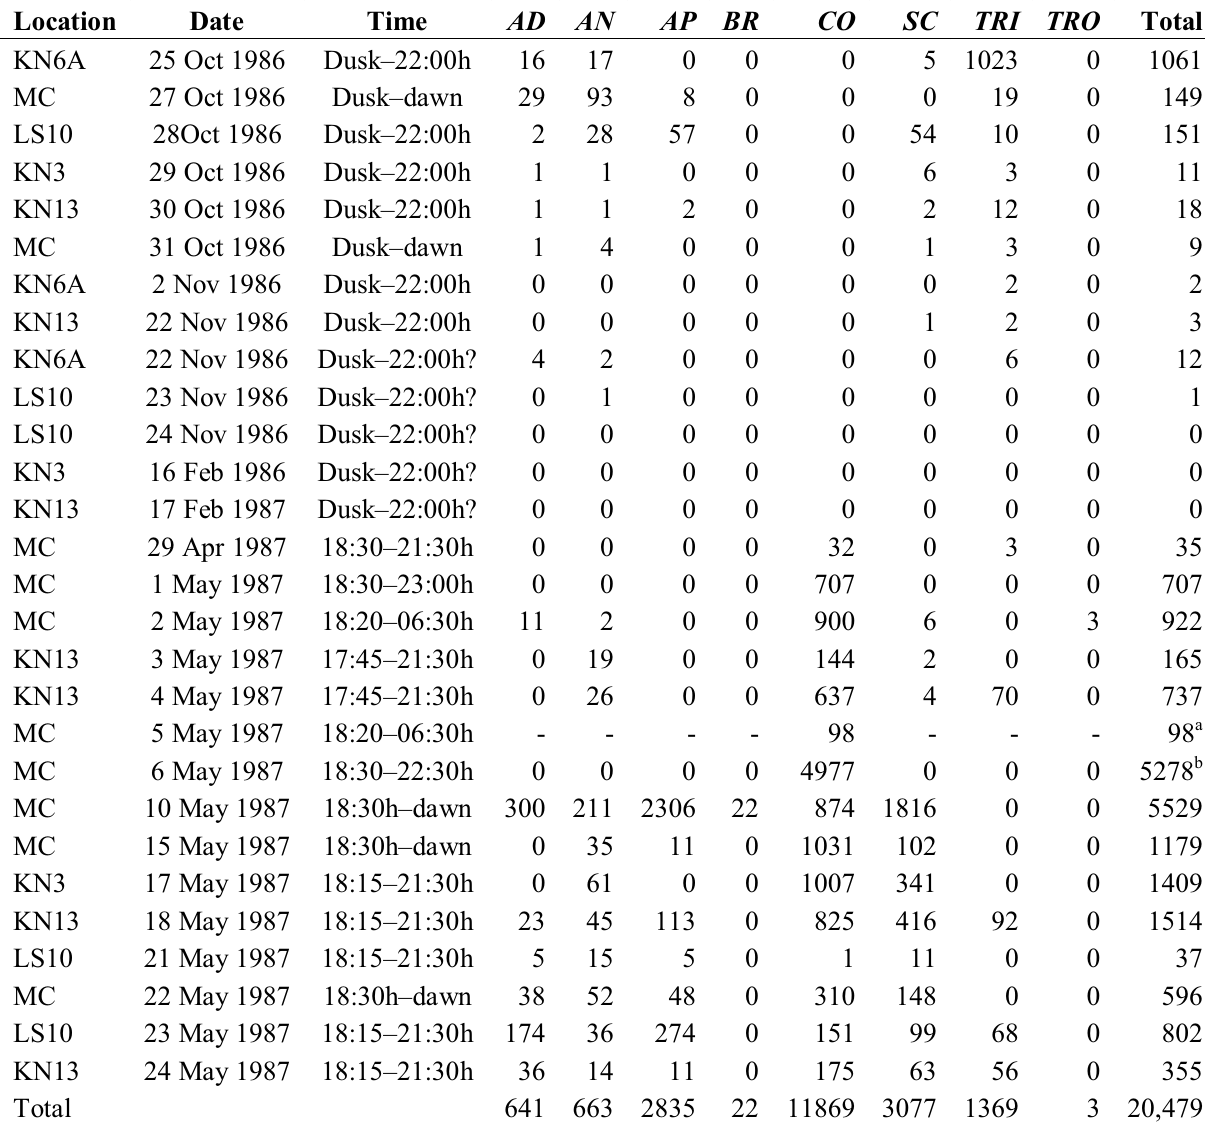
Table 5. Adult Scarabaeidae catches in the light trap, October 1986 to May 1987. Key to adults: AD Adoretus spp., AN Anomala spp., AP Apogonia spp., BR Brachylepis werneri , CO Cochliotis melolonthoides , SC Schizonycha spp., TRI Triodontella spp., TRO Trochala spp